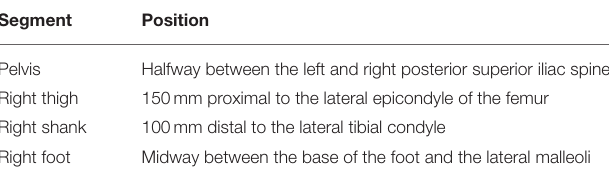
TABLE 2 | Temporal and kinematic measurement definitions. TABLE 3 | MARG device